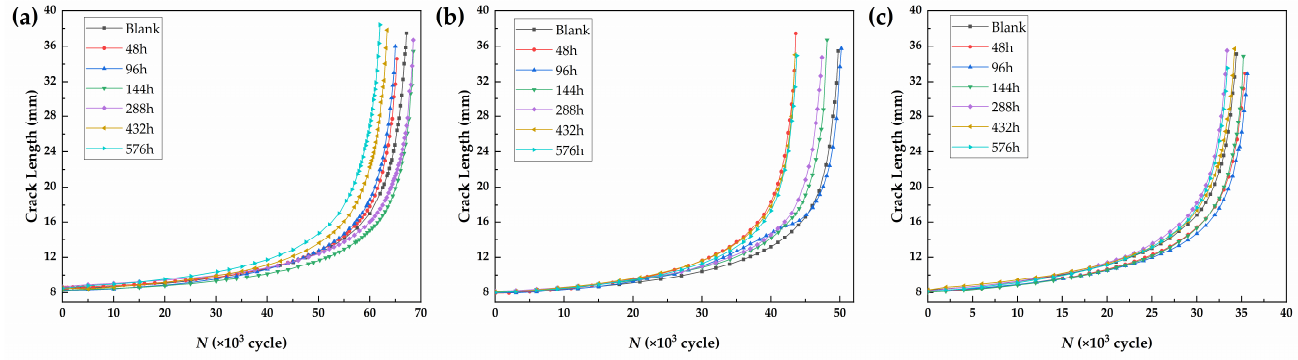
Figure 8. The curves of the fatigue crack length under mean stresses of ( a ) 5 MPa, ( b ) 7.5 MPa, and ( c ) 10 MPa.